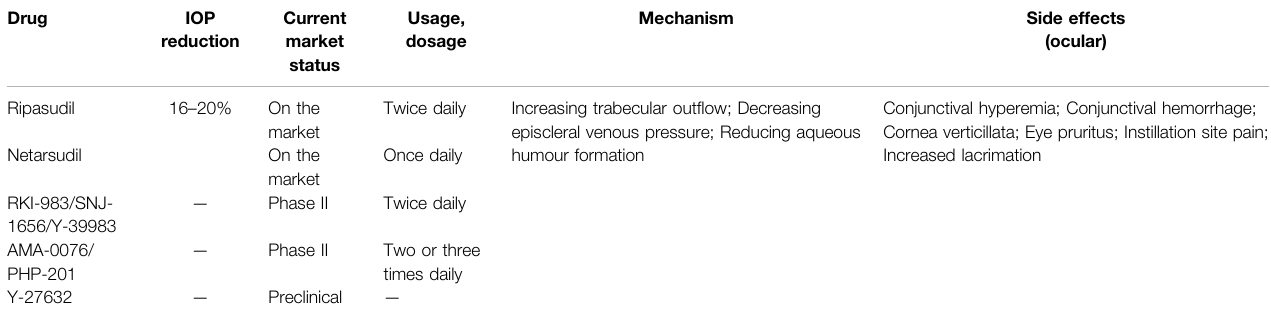
TABLE 2 | The class and list of Rho-kinase inhibitors.